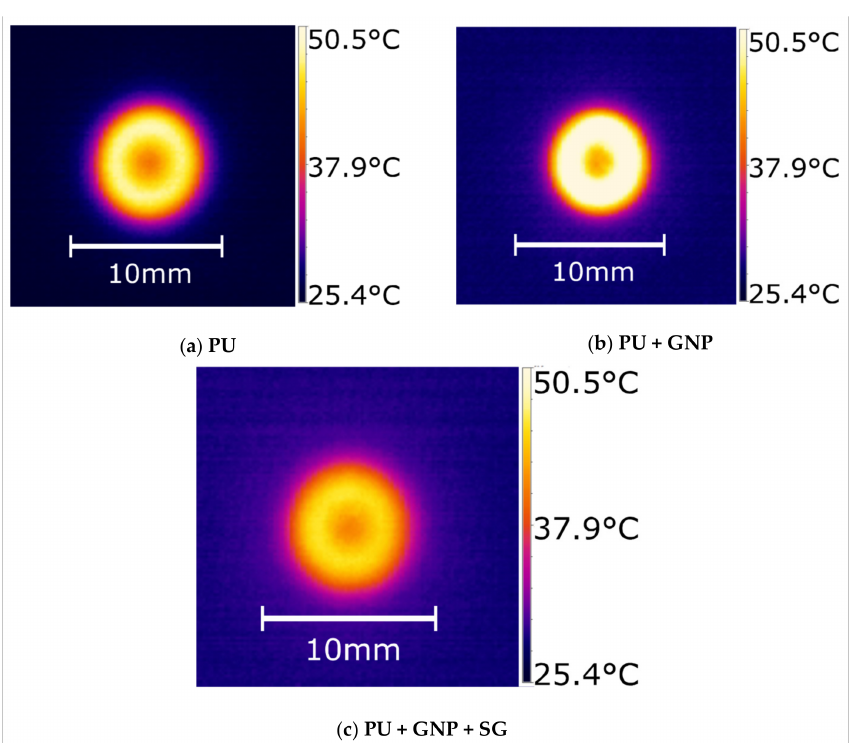
Figure 10. Thermographs of ( a ) PU impacted at 170.9 m/s, ( b ) PU + GNP impacted at 169.2 m/s, ( c ) PU + GNP + SG impacted at 170.5 m/s. These data where chosen as they closely match the same impact speed, and the high impact speed gives good thermal